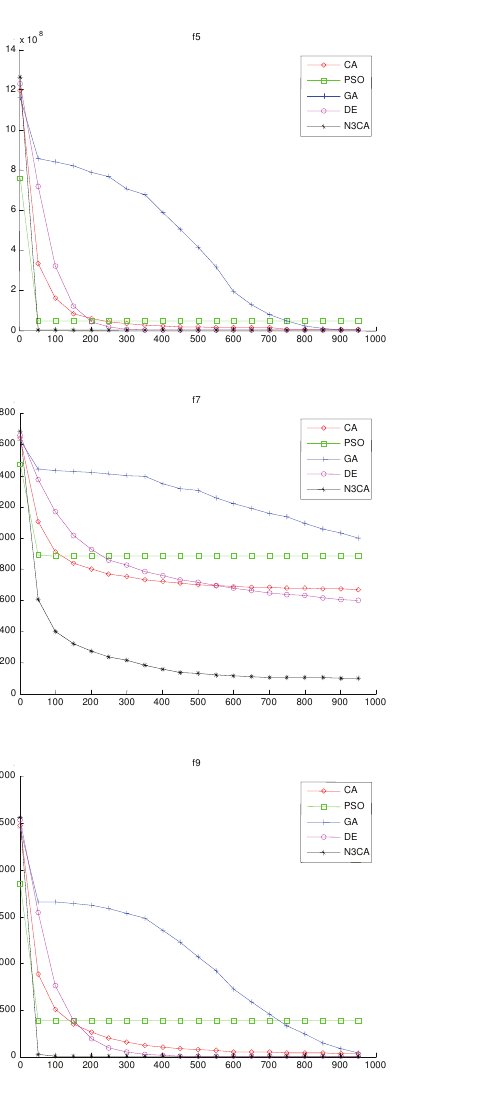
Fig. 4. ( Continued .) Convergence performance of the five algorithms on the 10 test functions. f 5, f 6, f 7 , f 8 , f 9 , f